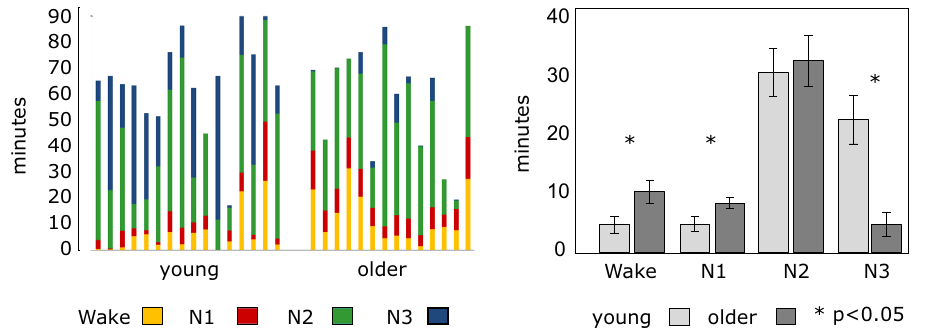
Figure 1. Duration of wakefulness and sleep stages recorded in the scanner. Left panel represents individuals’ times in wakefulness and each sleep stage (duration in min). Right panel represents group values in wakefulness and each sleep stage. Young participants are presented in light grey, older participants in darker grey. Duration of wakefulness, N1, N2, and N3 (mean ± SEM) were recorded in the scanner (after exclusion of EEG epochs associated with high motion in the fMRI series; see “Materials and methods”